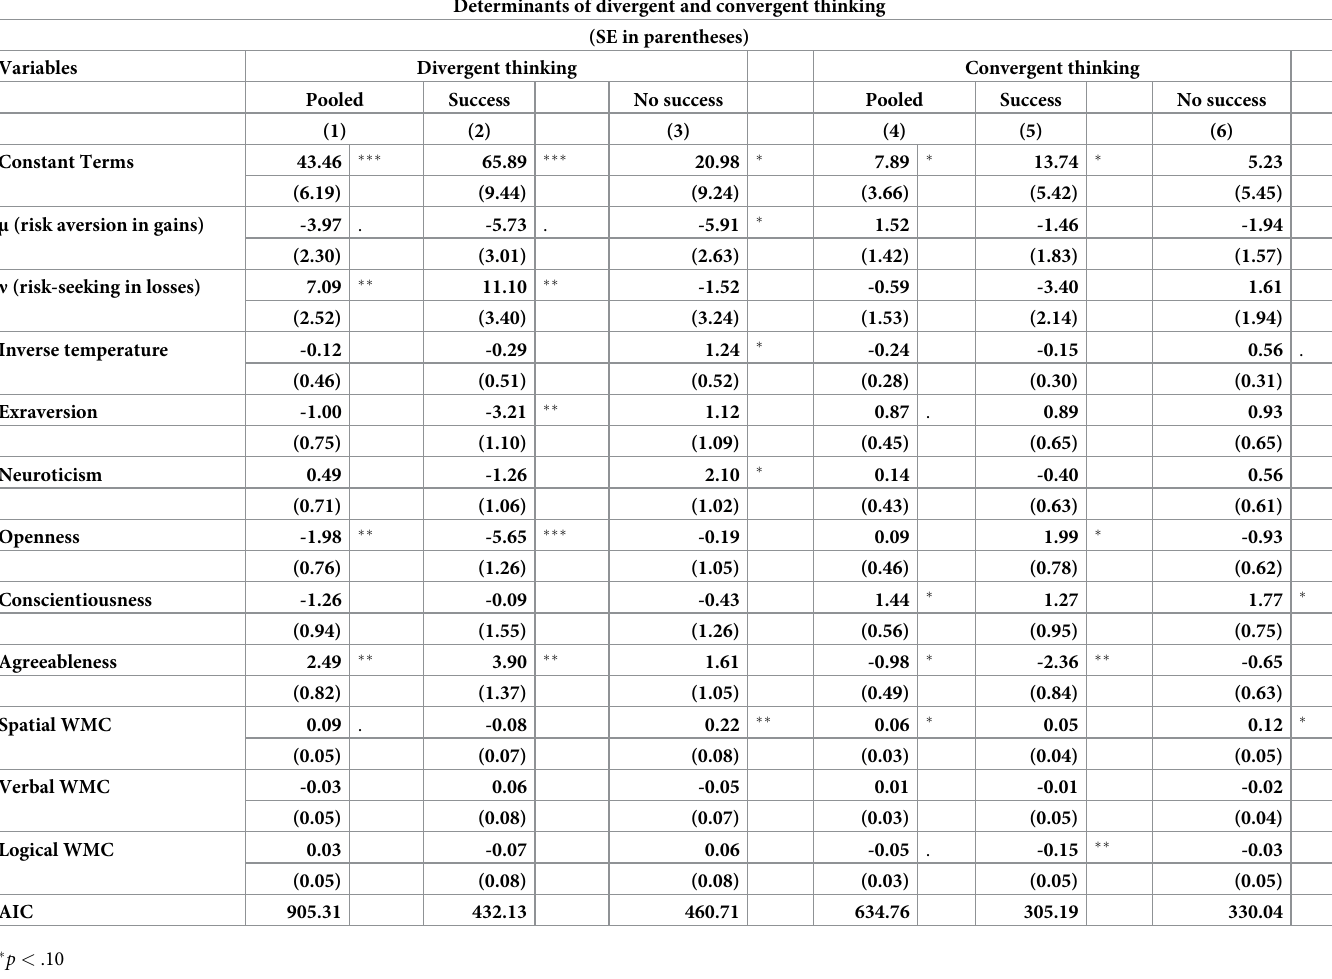
Table 2. Determinants of divergent and convergent